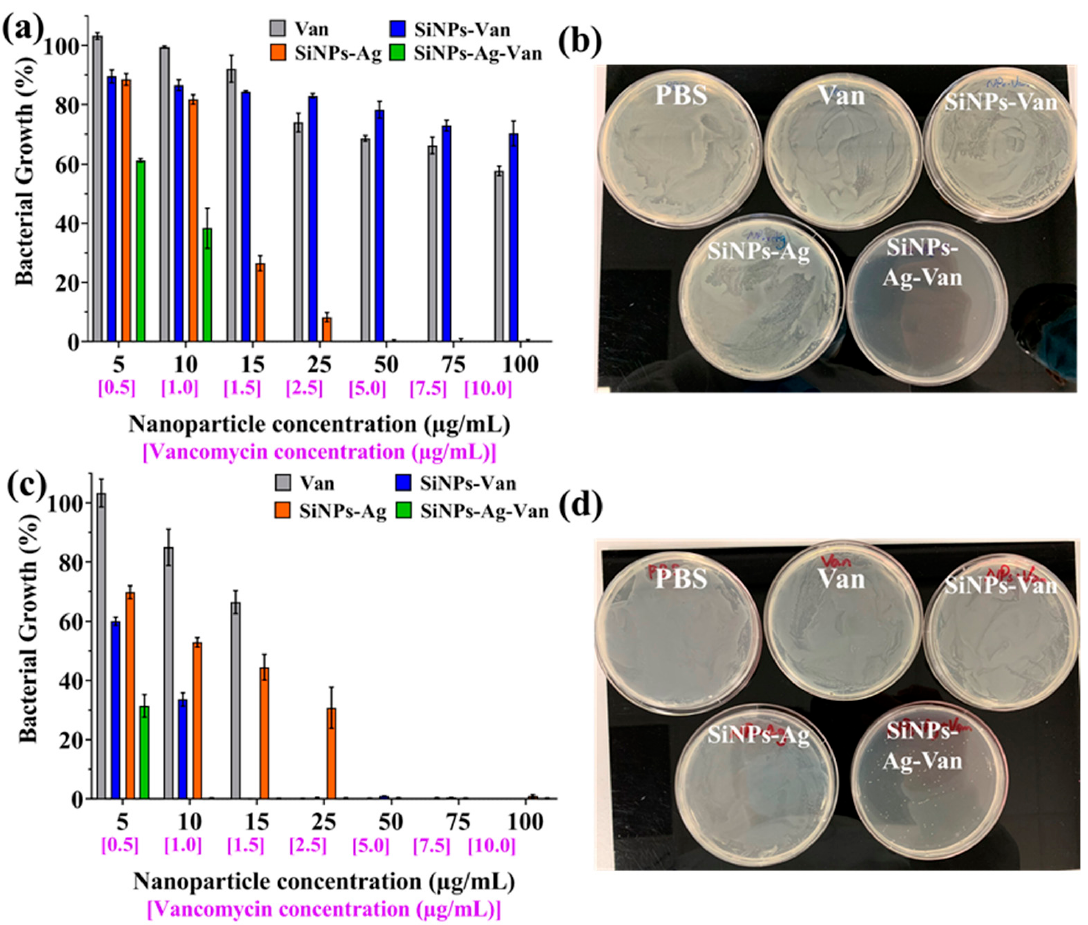
Figure 3. Antibacterial performance against E. coli ( a , b ) and S. epidermidis ( c , d ). Error bars represent standard derivations ( n = 3).